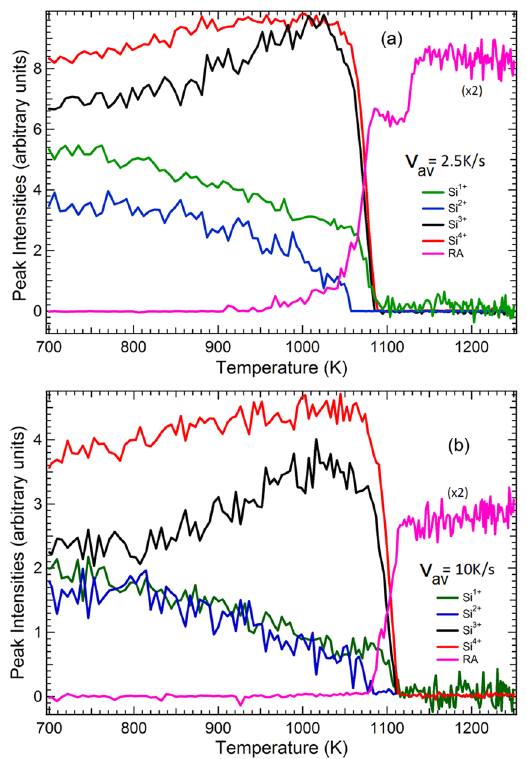
Figure 4. Temperature dependence of the Si oxide and suboxide intensities and of the RA contribution (pink line) for the temperature schedules ( a ) v av = 2.5 K.s − 1 and ( b ) v av = 10 K.s − 1 . Note that the Si 1 + intensity is set to zero after the desorption event due to an energy overlap with an elemental silicon component of the cleaned surface (see text).